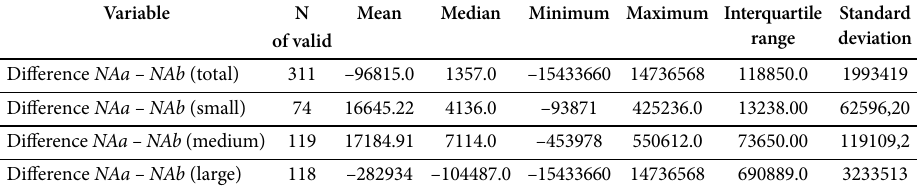
Table 5. Descriptive statistics of the net assets difference NAa–NAb by size